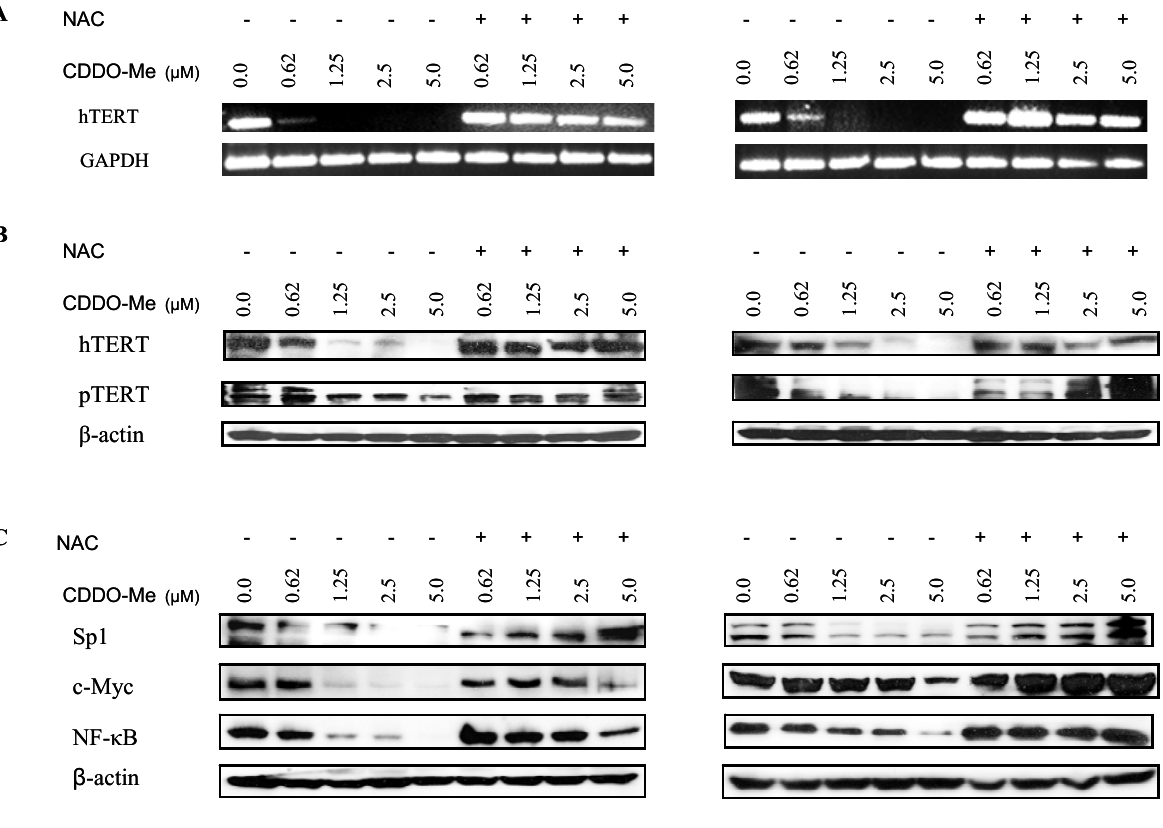
Figure 4. NAC blocks the inhibition of hTERT expression and hTERT related transcription factors by CDDO-Me. ( A) Effect on hTERT gene expression. Mia PaCa-2 and Panc-1 cells pretreated or not with NAC (3 mM) were treated with CDDO-Me (0–5 μ M) for 48 h and total cellular RNA was prepared using TRI-zole reagent. 1 μ g of cellular RNA was reverse transcribed using oligo-dt primer and high fidelity reverse transcriptase. 1 μ L of cDNA was amplified using hTERT or GAPDH primers. Amplified products were separated on 2% DNA agarose gel. Gels were stained with ethidium bromide and amplified DNA fragments were identified by base pair sizes; ( B ) Effect on hTERT protein. Mia PaCa-2 and Panc-1 cells were treated with CDDO-Me (0–5 μ M) for 48 h as above and cell lysates were analyzed for hTERT and p-hTERT protein by western blotting; ( C ) Effect on hTERT transcription factors. MiaPaCa-2 and Panc-1 cells were treated with CDDO-Me (0–5 μ M) for 48 h as in A and cell lysates were analyzed for c-Myc, Sp1, and NF- κ B by Western blotting. Each experiment was repeated at least two